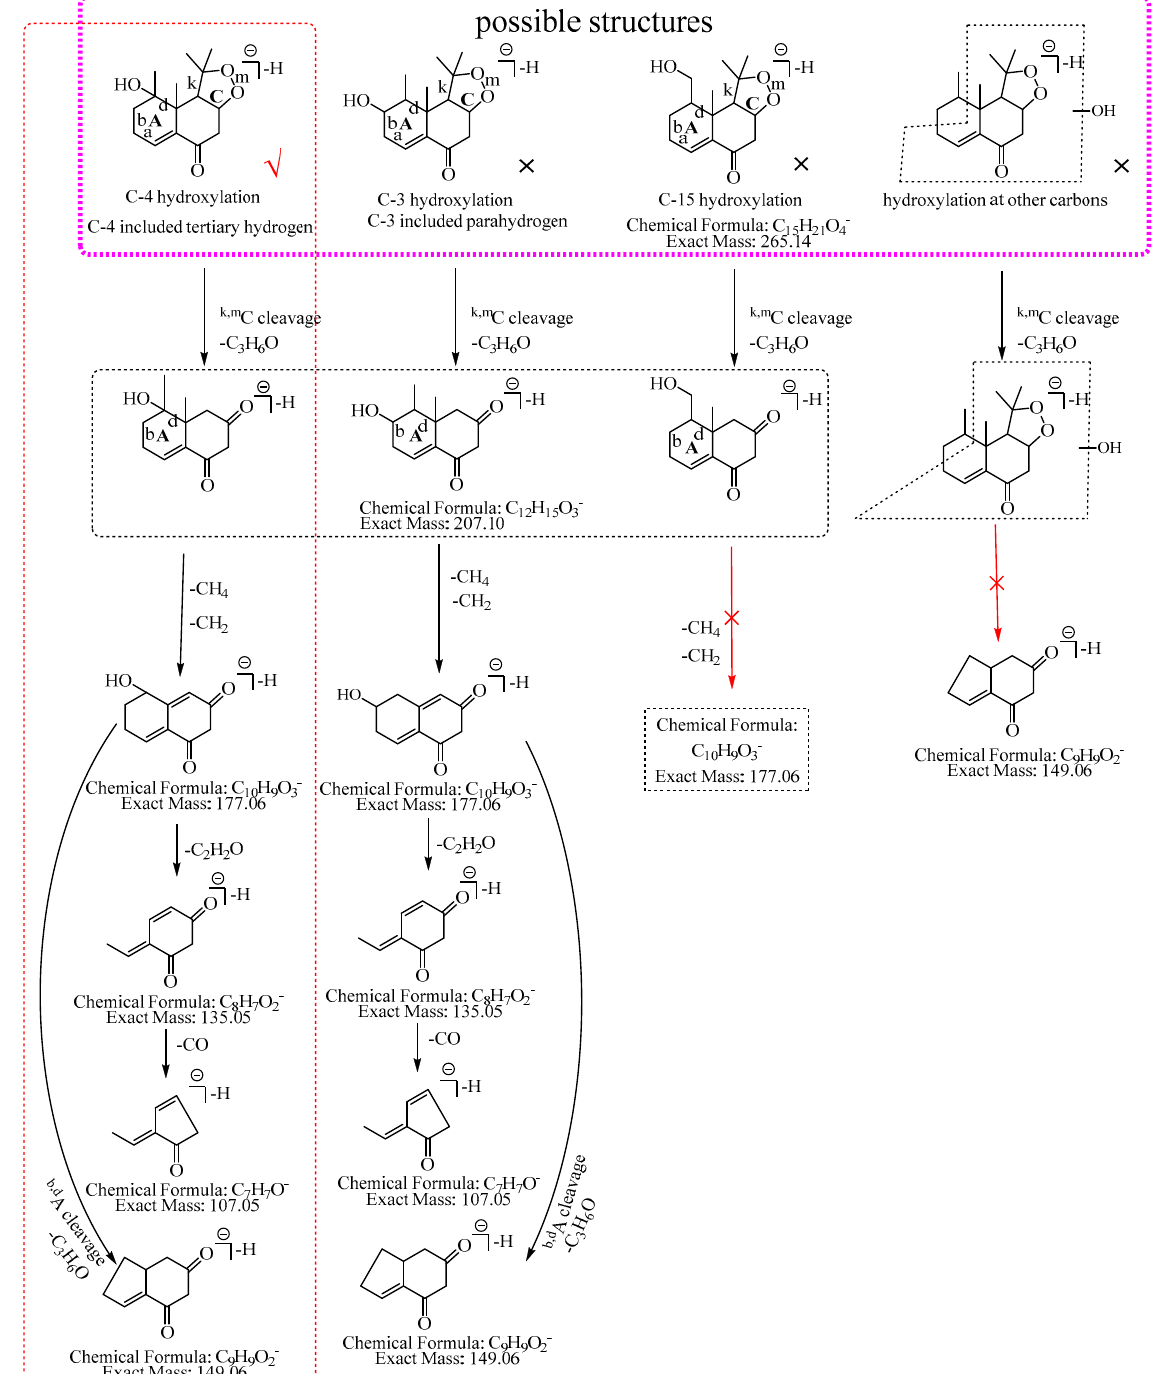
Figure 5. The proposed fragmentation pathways of M3 (4-hydroxyl nardosinone). “ √ ” represents the possible structure. “×” represents the impossible structure. The purple rim represents the possible structures; A and C represent the hexatomic rings, respectively. The red rim represents the most possible fragmentation pathway.